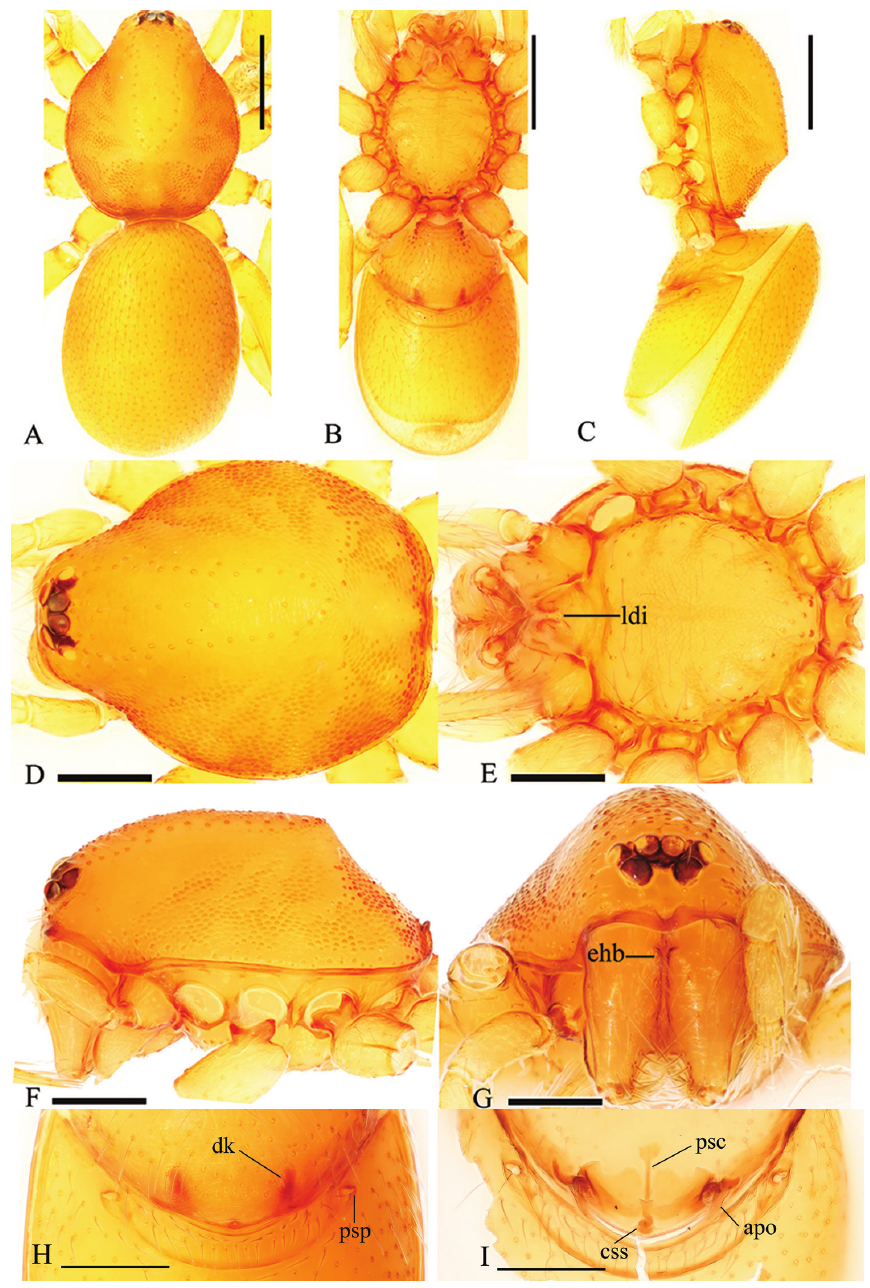
Figure 10. Trilacuna songyuae sp. n., female. A, B, C habitus, dorsal, ventral and lateral views D, E, F, G prosoma, dorsal, ventral, lateral and anterior views H, I genitalia, ventral and dorsal views. Abbreviations: apo = apodemes; css = cone-shaped structure; dk = dark knob; ehb = elevated hair base; ldi = labium deep incision; psc = paddle-like sclerite; psp = posterior spiracles. Scale bars: 0.2 mm ( A–C ); 0.1 mm ( D–I